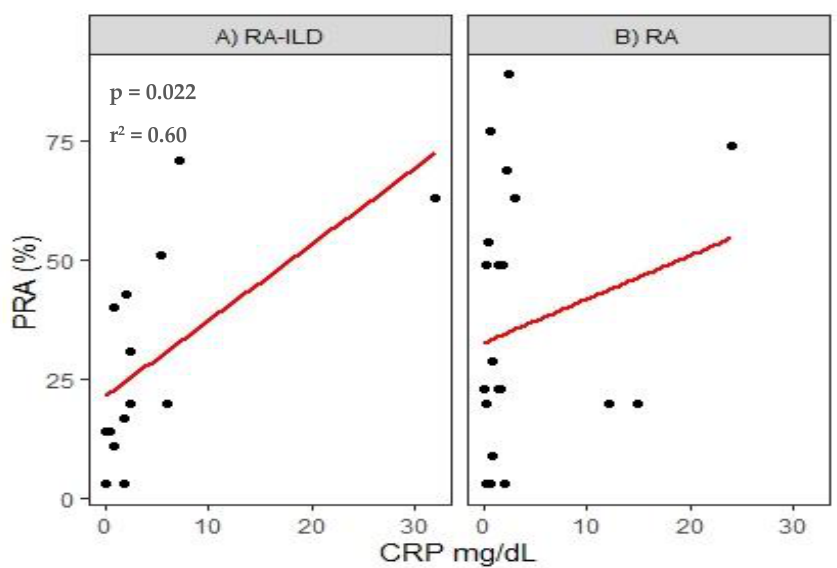
Figure 2. Correlation of CRP levels with PRA (%) in rheumatoid arthritis (RA) patients with or without ILD.